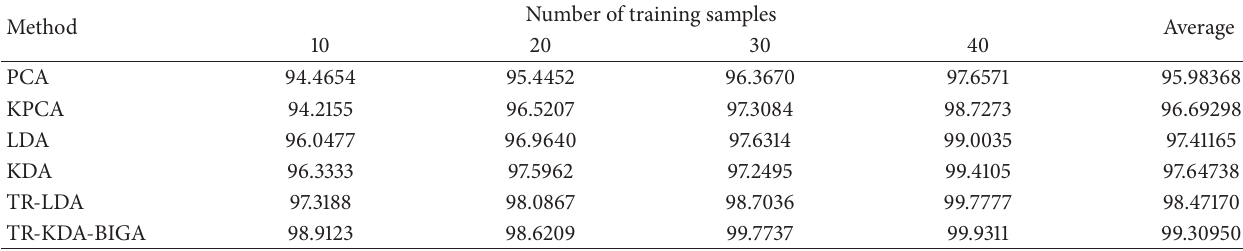
Table 6: Classification accuracy of bearing data under 2 HP motor load.